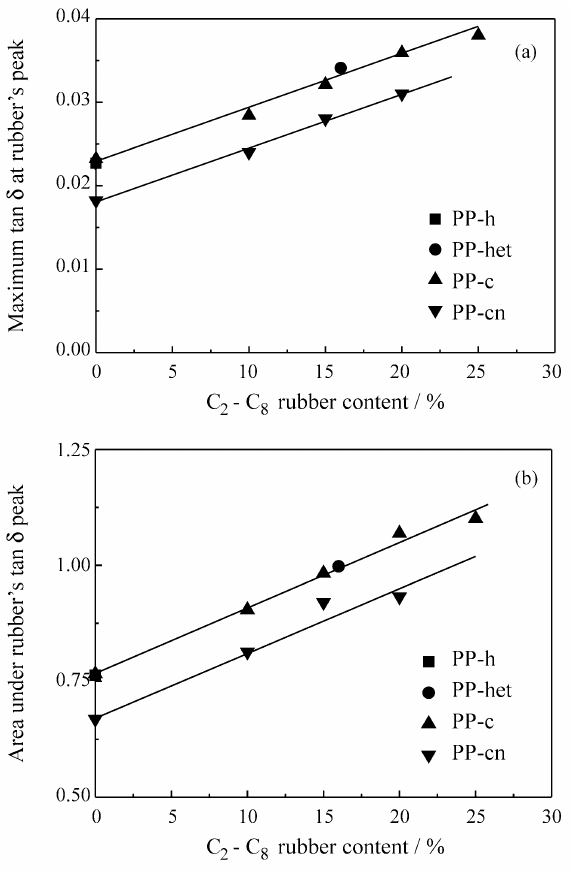
Figure 3. Maximum intensity at the β peak temperature and its area as a function of elastomer content for the copolymers and their blends.